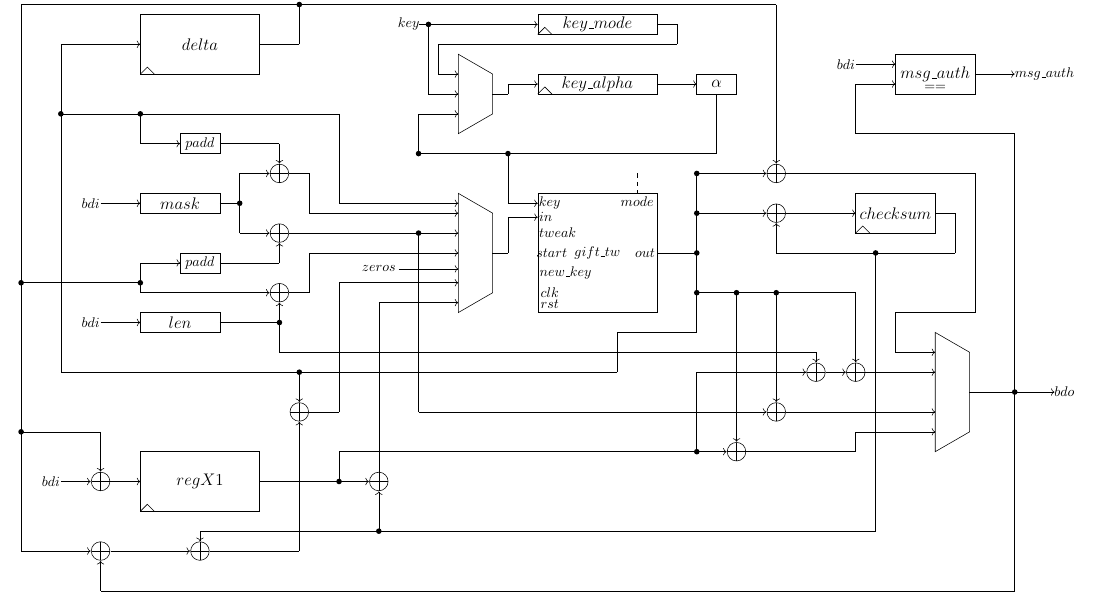
Figure 3. LOTUS/LOCUS hardware